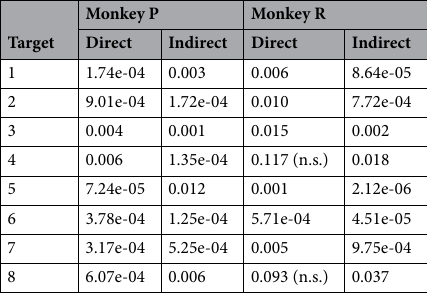
Table 1. Relative variance within target. P-values from unpaired t-test comparing relative neural variance in early and late learning calculated within each target separately.